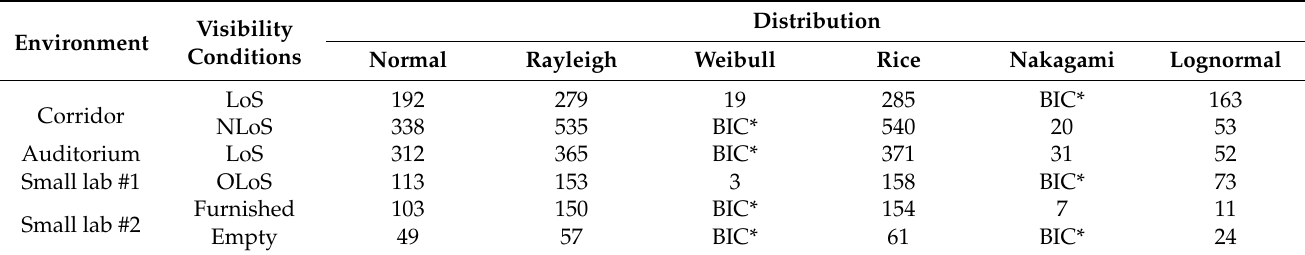
Table 1. ∆ BIC values at different measurement environments, at 3.5 GHz response.